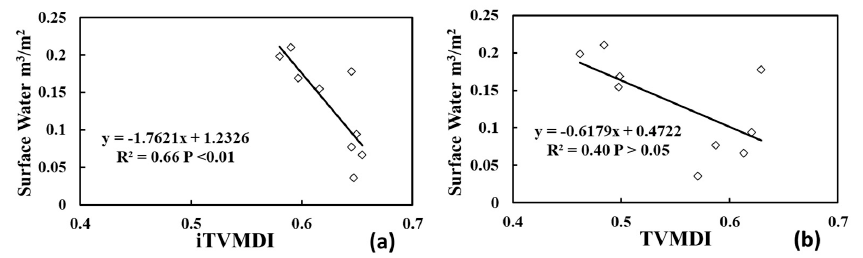
Figure 6. The relationship between drought indices and surface water: ( a ) iTVMDI and ( b ) TVMDI.